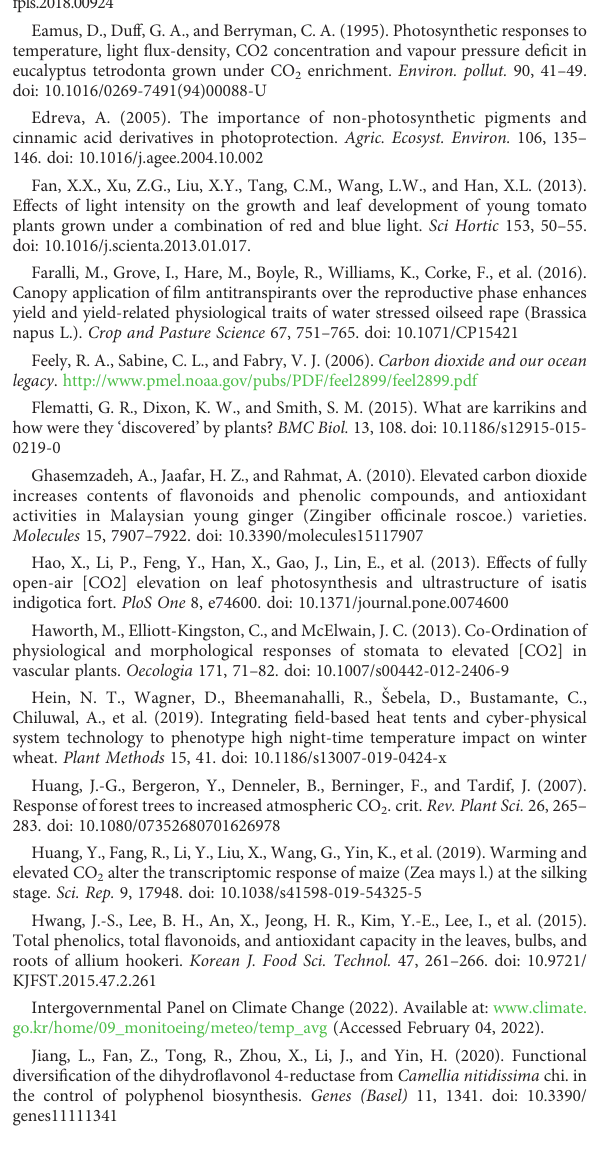
SUPPLEMENTARY FIGURE 4 Environmental factors and nutrient solution characteristics after light intensity treatment for fi ve weeks. (A) Environmental factors (CO 2 concentration, and atmospheric temperature and humidity). (B) Nutrient solution (electrical conductivity, pH, dissolved oxygen). The background colors represent the different light mean ± standard deviation (n = 9). The line symbols indicate the light intensity treatment (circle; 12 lx, triangle; 24